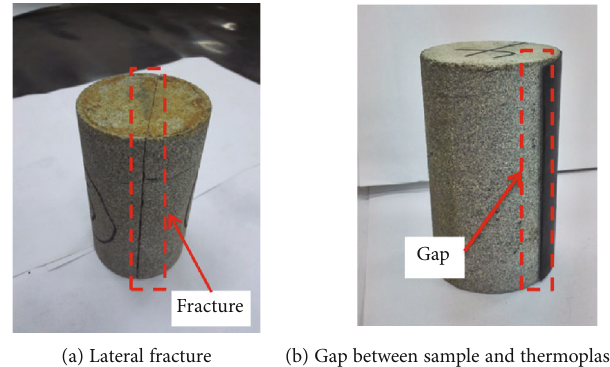
Figure 9: Fracture and the gap between sample and thermoplastic